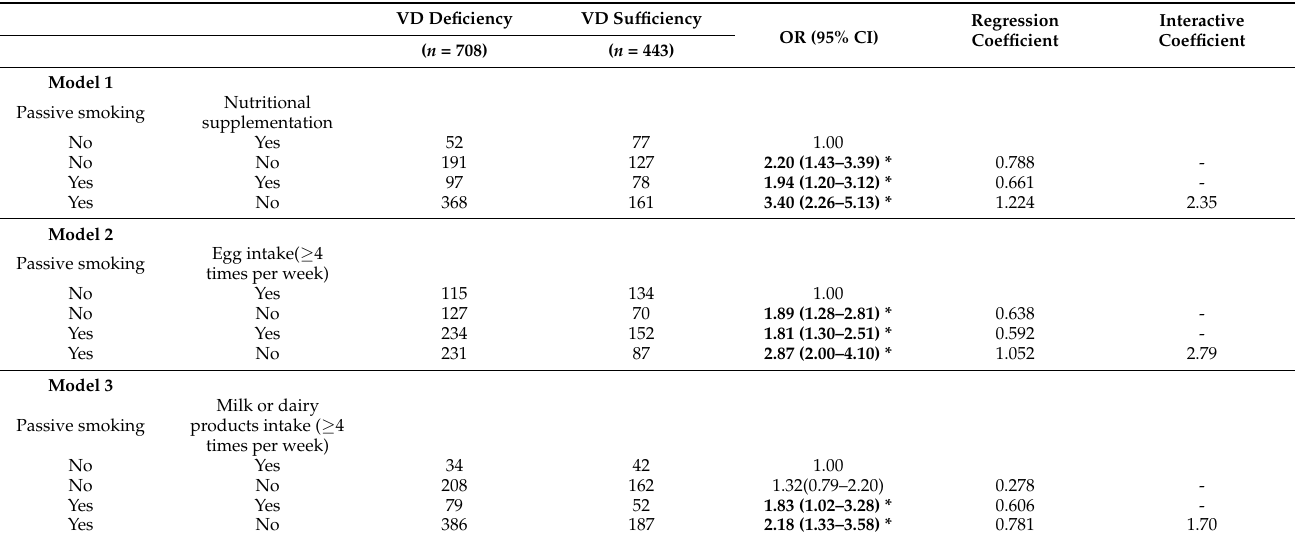
Table 4. The interaction between passive smoking and nutrition on the risk of VD deficiency. VD Deficiency VD Sufficiency